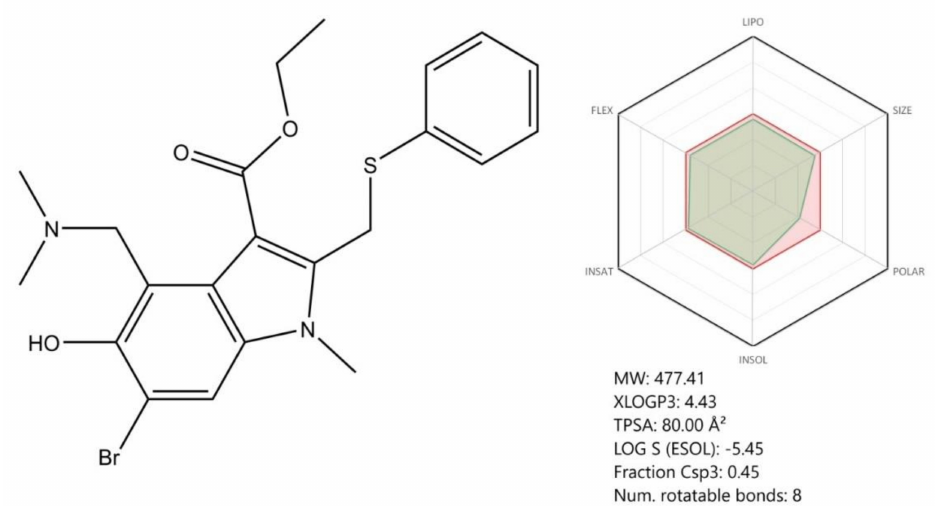
Figure 12. Chemical structure of Umifenovir; ADME profile was achieved using the free web tool SwissADME; the red highlighted area represents the suitable physicochemical space for oral bioavailability covering value intervals for the following: LIPO (lipophility): − 0.7 < XLOGP3 < + 5.0, SIZE: 150 g / mol < MV < 500 g / mol, POLAR (polarity): 20Å 2 < TPSA < 130Å 2 , INSOLU (insolubility): 0 < Log S (ESOL) < 6, INSATU (insaturation): 0.25 < Fraction Csp3 < 1, FLEX (flexibility): 0 < Num. rotatable bonds < 9, whereas the overlapped green highlighted area shows the calculated ADME profile for the molecule